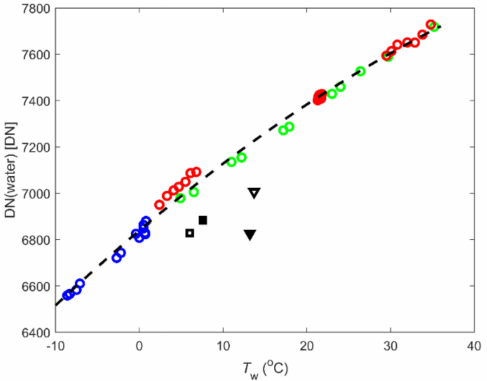
Figure 2. Scatter plot of the DN of the water surface (uncorrected) as a function of T w ( ◦ C), with circles indicating laboratory measurements in green T air / T w = 19.8 ± 0.2/6–35 ◦ C, red 22 ± 2/4–35 ◦ C, and blue 19.5 ± 0.5/ − 9–1 ◦ C; black squares/triangles indicate the April/August field surveys, with open/filled symbols representing day/night. The dashed line indicates Equation (7).